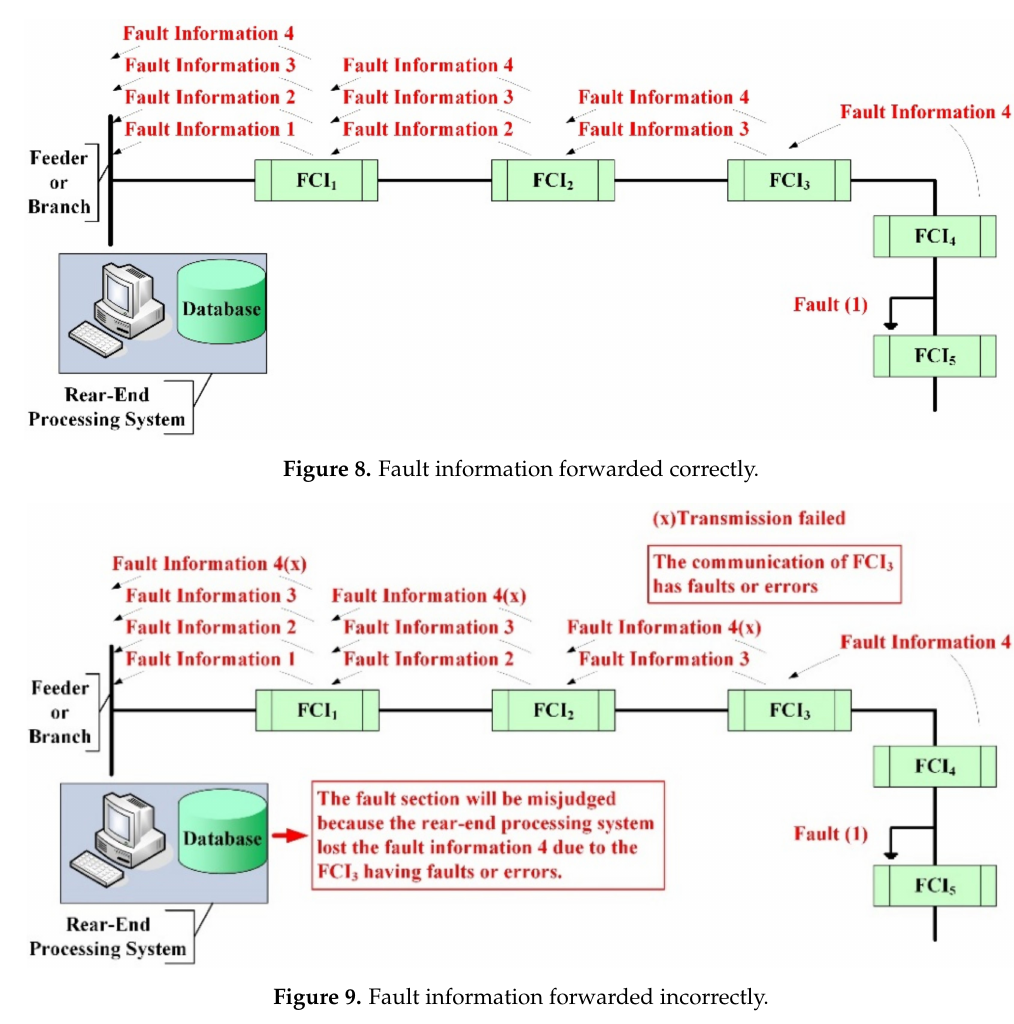
Figure 9. Fault information forwarded